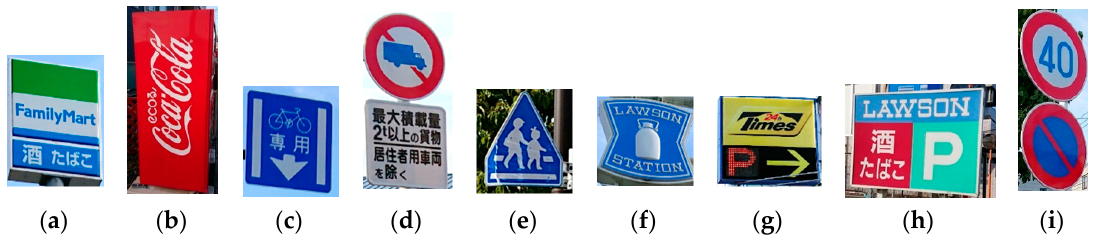
Figure 7. Landmarks used in the experiments: ( a ) ‘FamilyMart’; ( b ) ‘CocaCola’; ( c ) ‘BicycleLane’; ( d ) ‘NoTruck’; ( e ) ‘Crossing’; ( f ) ‘Lawson’; ( g ) ‘TimesParking’; ( h ) ‘LawsonParking’; ( i ) ‘RoadSign 1’.